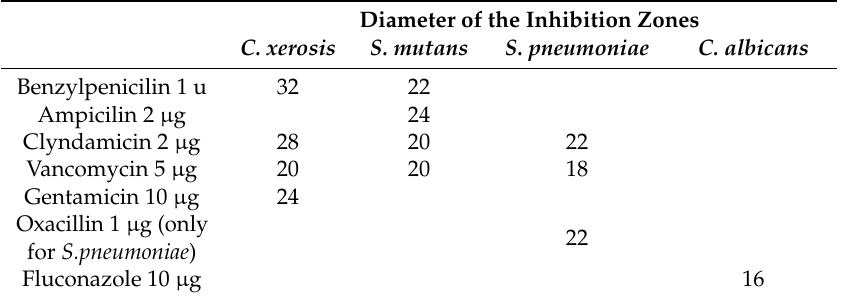
Table 1. Mean values of diameters of zones of inhibition in mm for CLSI reference